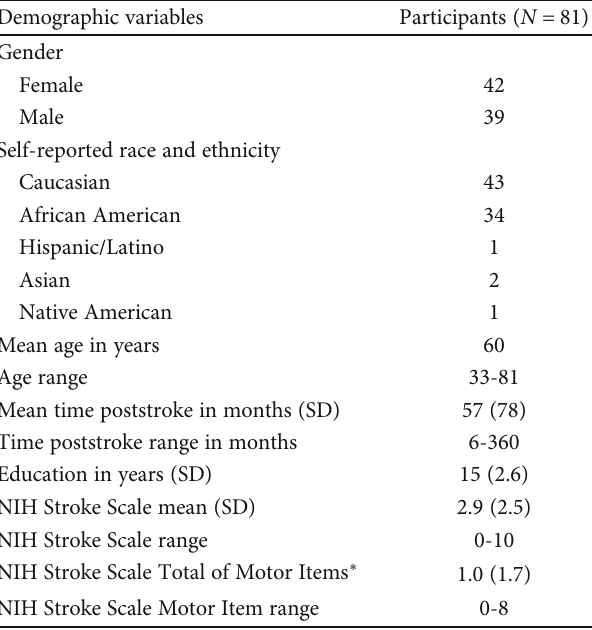
Table 1: Demographic characteristics of